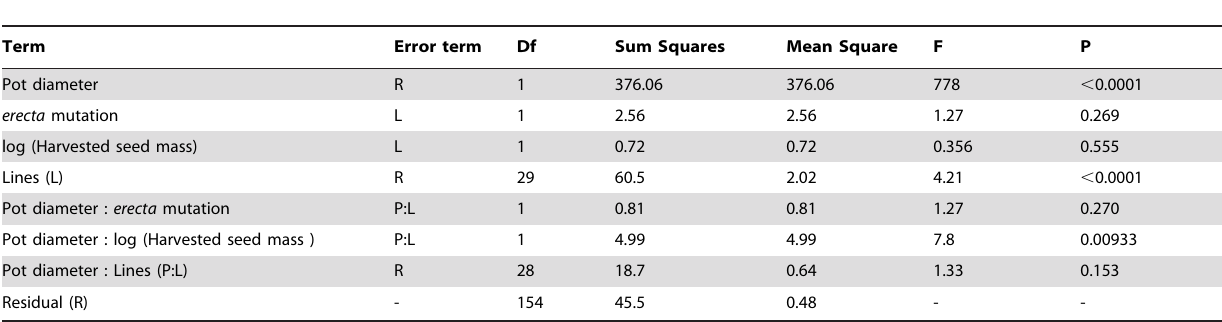
Table 5. ANOVA of the total mass of seeds with harvested seed mass fitted as an explanatory variable.